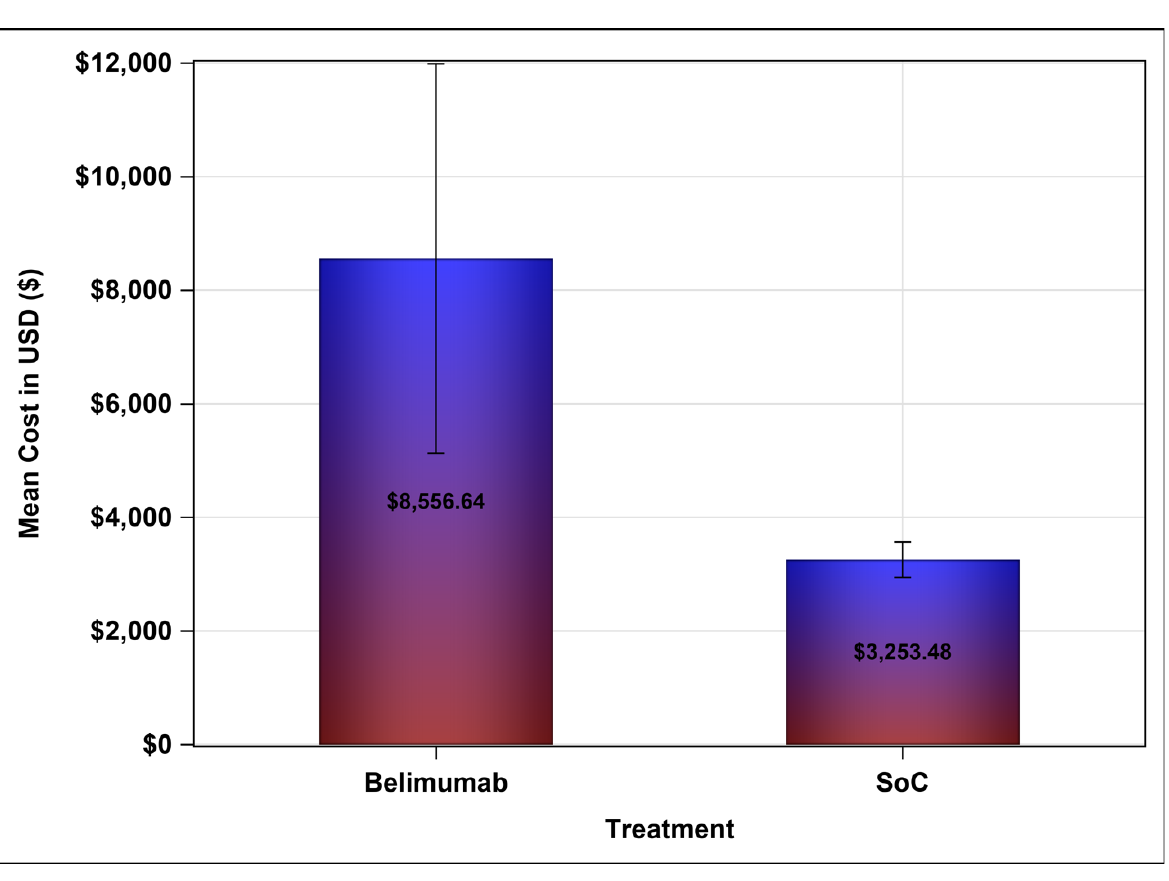
Table 2. The mean Systemic Lupus Erythematosus Disease Activity Index 2000 (SLEDAI–2K) score difference between the baseline and follow-up period and treatment costs for a belimumab-based treatment regimen versus the standard of care (SoC).